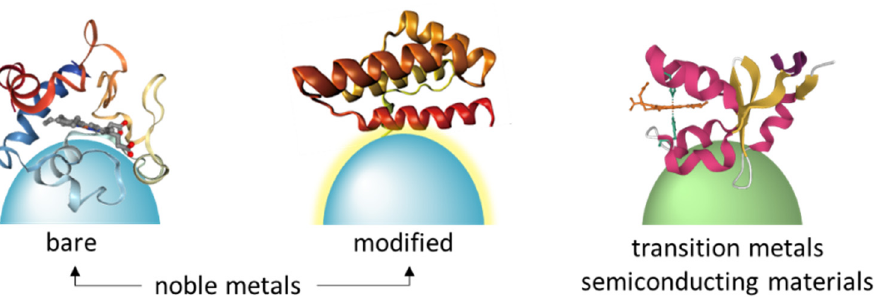
Figure 2. Immobilization of proteins onto SERS-materials.